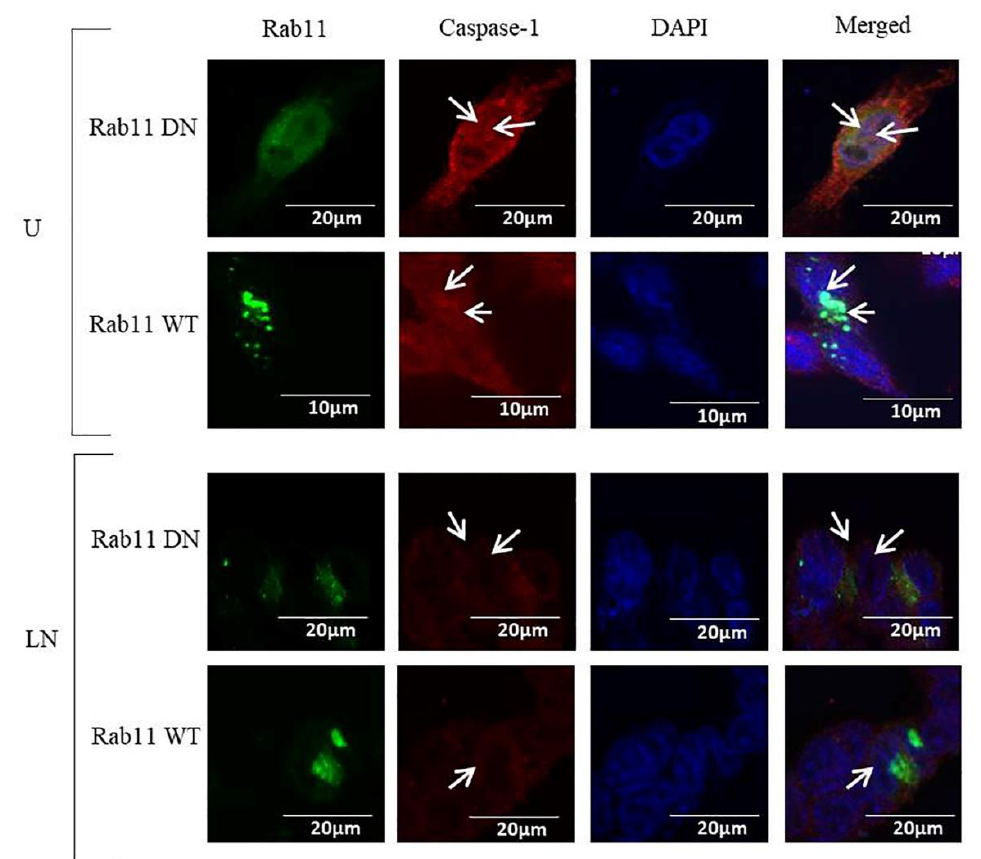
Figure 7. The effects of DN Rab11 and WT Rab11 on the localization of caspase-1 in HCT116 cells. Nigericin (20 µM) treatment for 24 hours and three hours of pre-incubation with LPS (1 µg/ml) were used to activate the NALP3 inflammasome after the transfection of pDsRed-rab11-WT and pDsRed-rab11-DN to the HCT116 cells. Caspase-1 was found only in the nuclei and cytosol in the control and LPS/nigericin-treated DN Rab11 and WT Rab11 cells. Arrows show the localisation of caspase-1. DN and WT Rab11 proteins were visualized using green coloring with a 488 nm excitation wavelength. Caspase-1 was visualized using a 590 nm excitation wavelength and red coloring. The nucleus was visualized using DAPI. U: untreated; LN: LPS/nigericin; DN: dominant negative; WT: wild type ( n = 3 for each experiment).